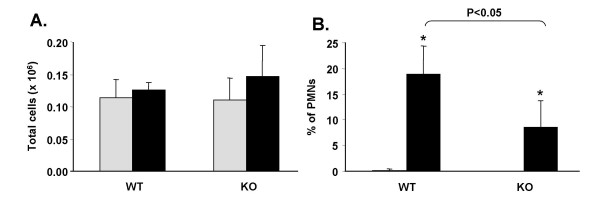
Characteristics of BAL cells. Following BAL the cells were removed by centrifugation and counted. Total cell numbers (A) were determined from an aliquot of cell suspension applied to a hemocytometer. Differential cell counts (B) were obtained by making cytocentrifuge preparations of BAL cells and doing differential cell counts. Gray bars represent FA-exposed samples and black bars represent ozone-exposed samples. Note that FA-exposed values are plotted in B, but values are very small (0.125% and 0% for WT and KO, respectively). Comparisons that were significantly different are indicated by a bracket and p-values.